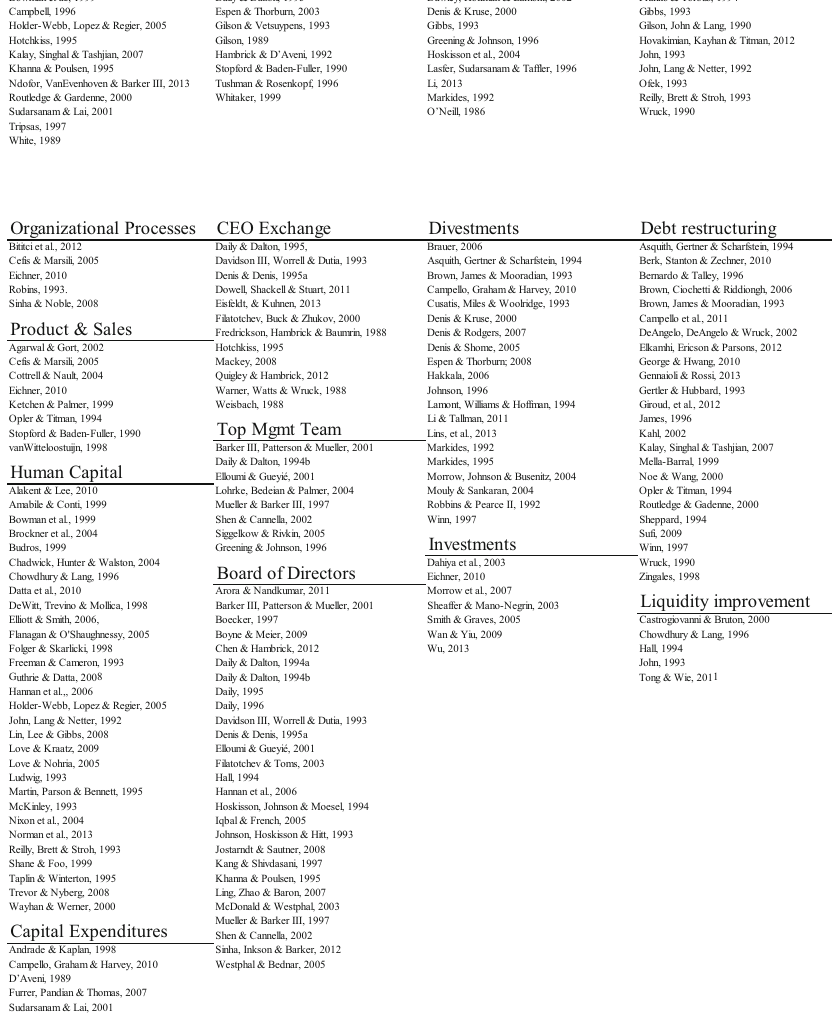
Fig. 4 Literature overview according to the